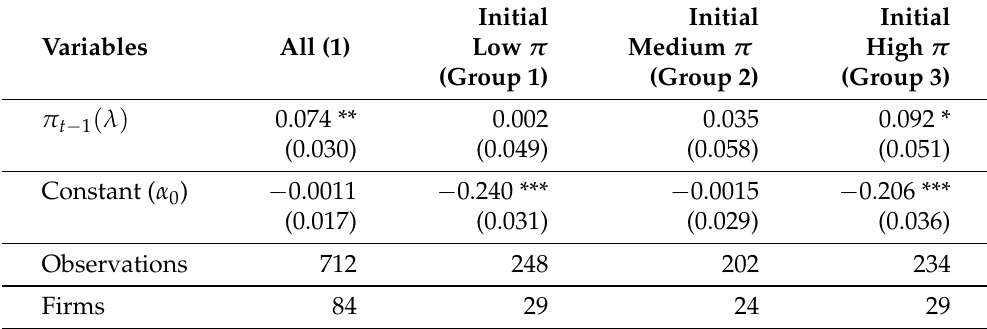
Table 2. Result from Model 1 (profit